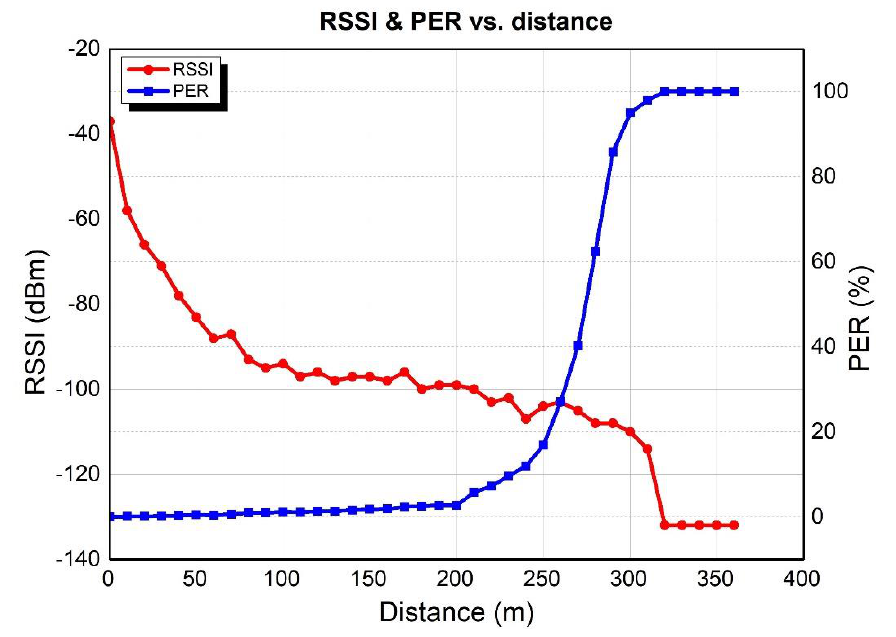
Figure 12. RSSI and PER measurements from RX module, recorded as distance in the NLOS envi- ronment.